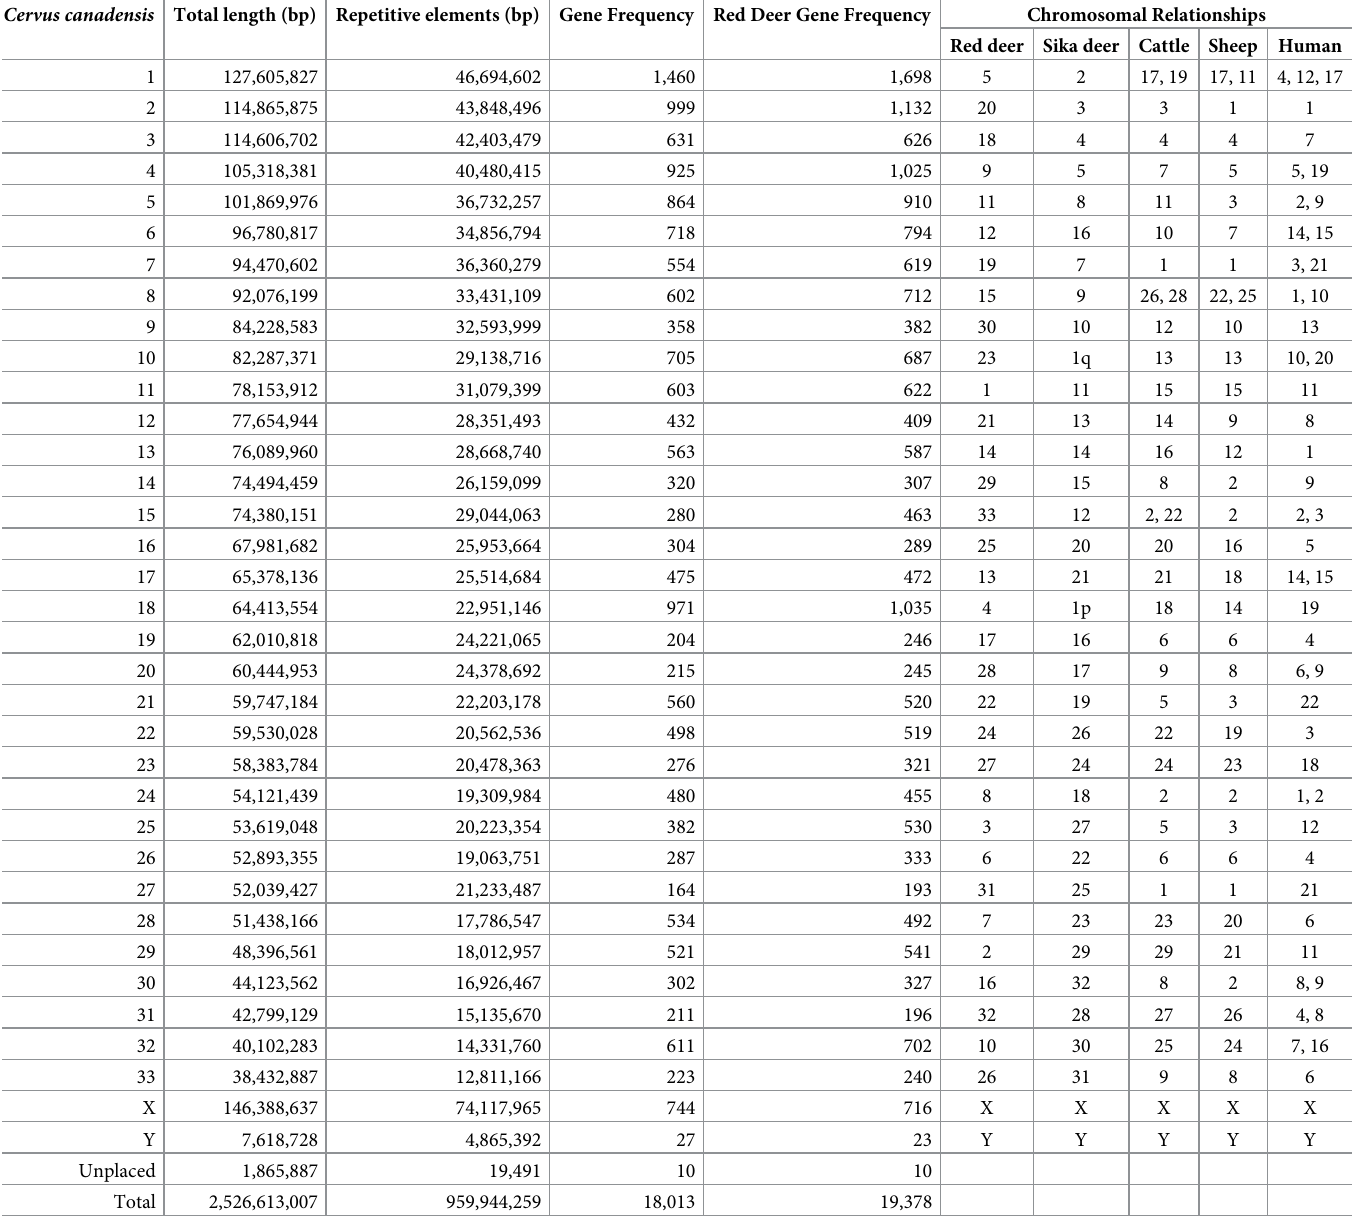
Table 1. Chromosome statistics of the Rocky Mountain elk assembly compared to red deer, with syntenic relationships to red deer, sika deer, cattle, sheep and human. Cervus canadensis Total length (bp) Repetitive elements (bp) Gene Frequency Red Deer Gene Frequency Chromosomal Relationships